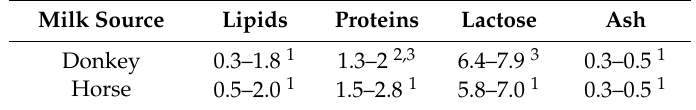
Table 1. Chemical composition (g / 100 g) of donkey and mare